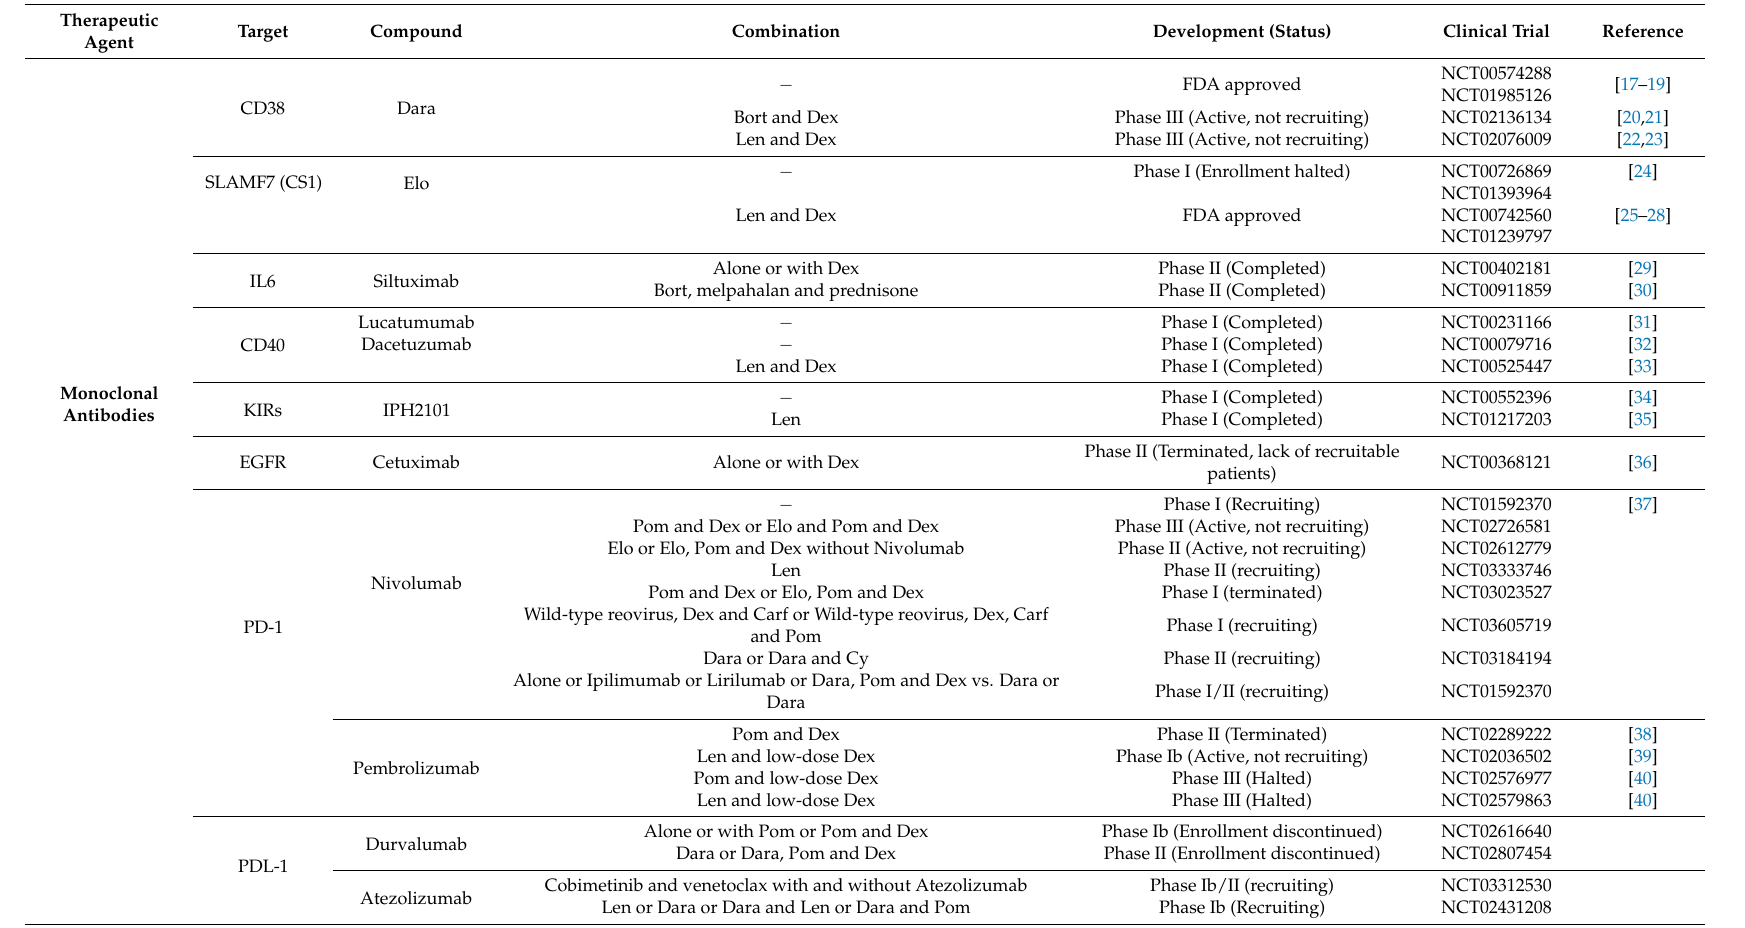
Table 1. Main Clinical trials already finished or on-going with the different immunotherapy options in relapsed/refractory multiple myeloma